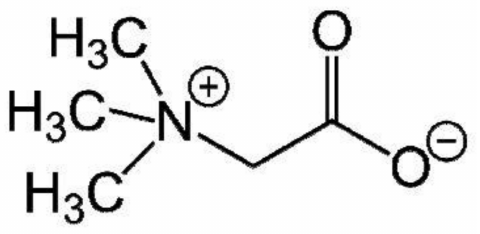
Figure 1. Betaine chemical